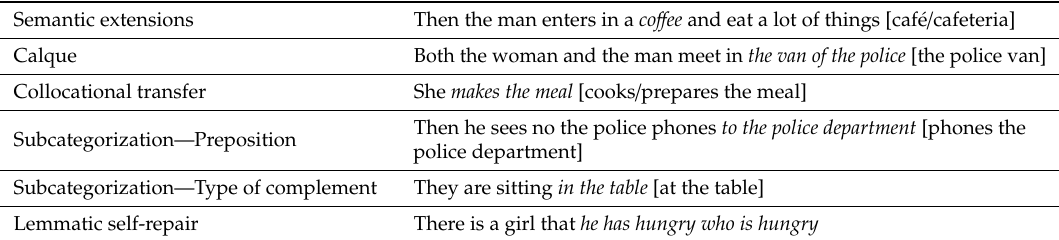
Table 2. Classification of lemmatic CLI and examples from the data.